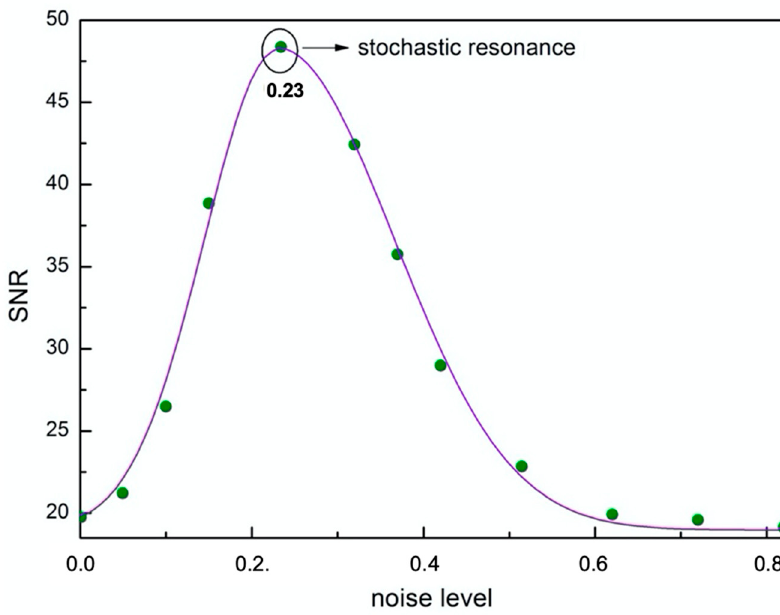
Figure 7. Signal-to-noise ratio, i.e., SNR values, as obtained from the WT scalogram of the generalized Langevin’s solution, versus the noise level.